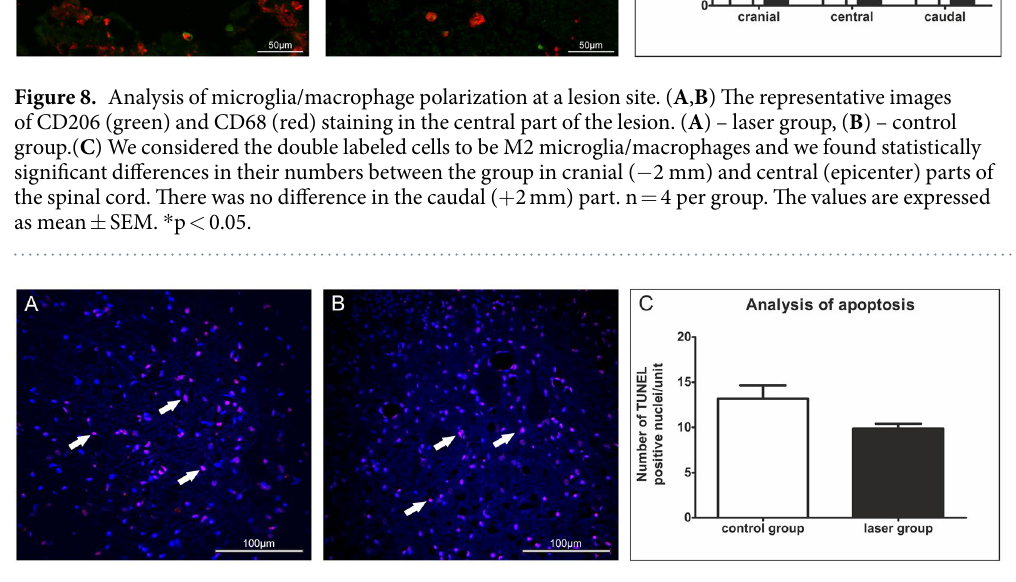
Figure 9. Analysis of apoptotic cells using TUNEL staining. ( A , B ) The representative images of TUNEL staining in the caudal part of the lesion. White arrows show the TUNEL and DAPI labeled nuclei. ( A ) – laser group, ( B ) – control group. ( C ) We observed a trend in the apoptosis decrease after laser treatment but it was not statistically significant. n = 4 per group. The values are expressed as mean ±